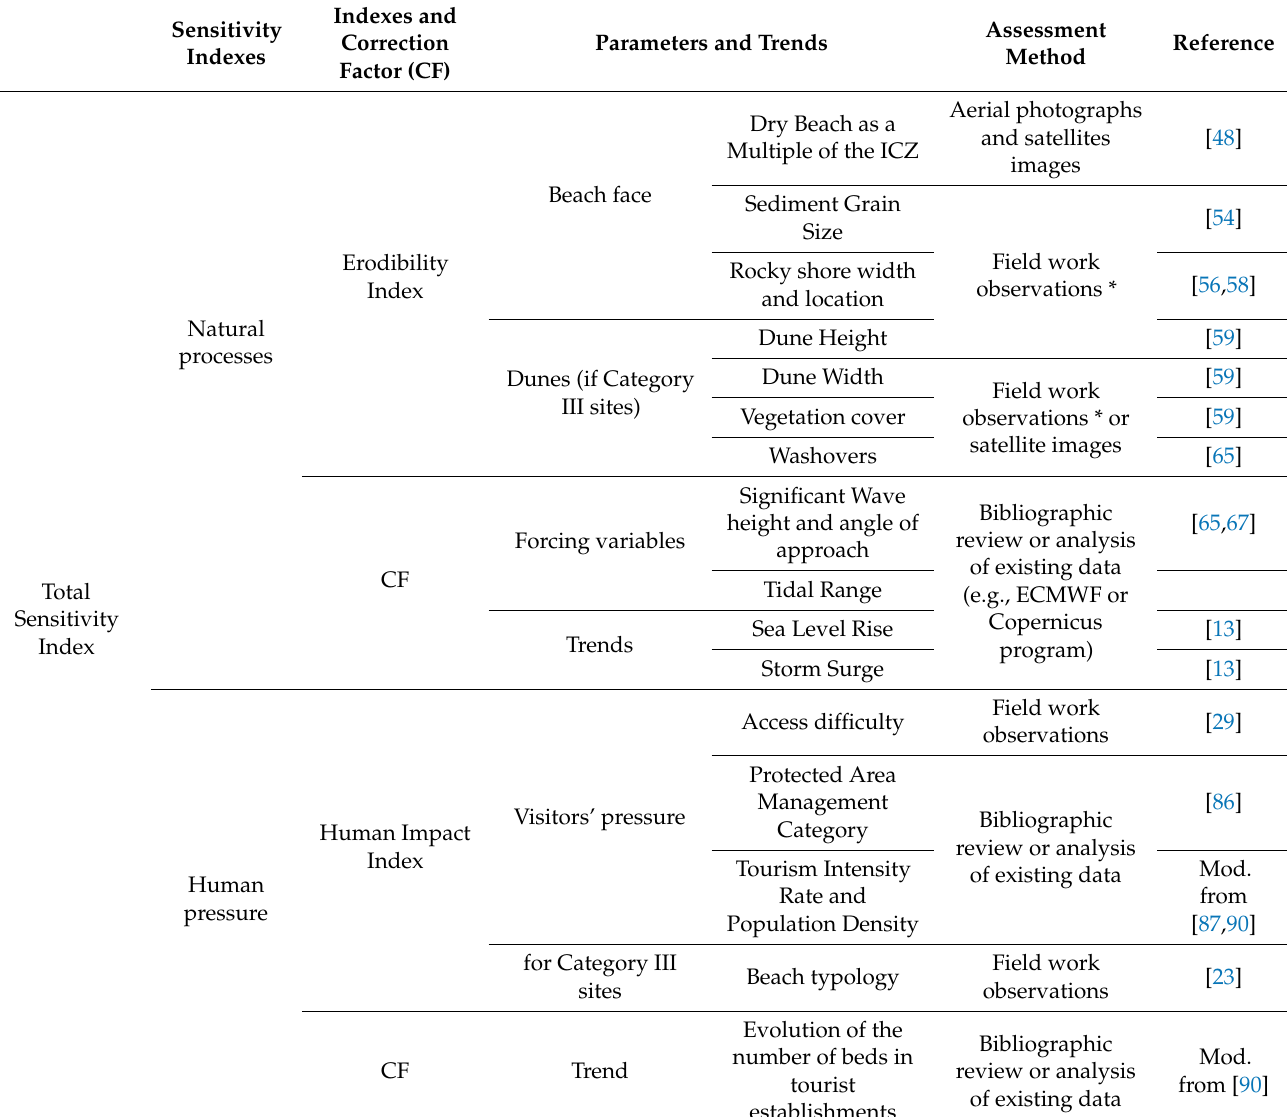
Table 1. Summary of indexes, parameters, trends, correction factors and sources used for sensitivity